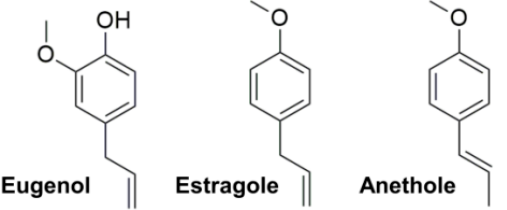
Figure 1. Chemical structure of eugenol, estragole, and anethole.